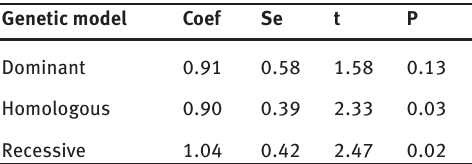
Table 3: Publication analysis by Egger’s line regression test in different genetic models.